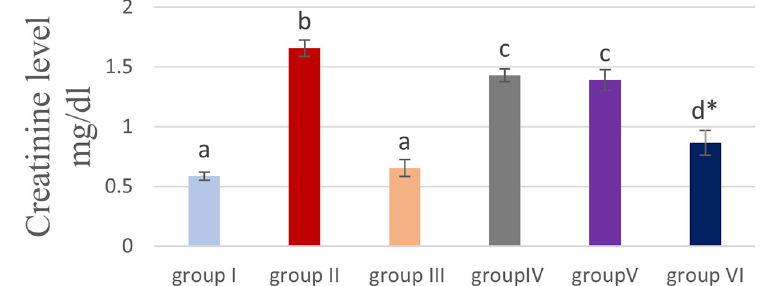
Figure 4. Showing the effect of cyanocobalamin on plasma creatinine level. - Each value represents mean (cid:3) standard error of means (SEM) (N=7/Group), - Values expressed in non-identical letters ( a, b,c ,d) are significantly difference (P<0.05), - *Highly significant difference from MTX P<0.01.